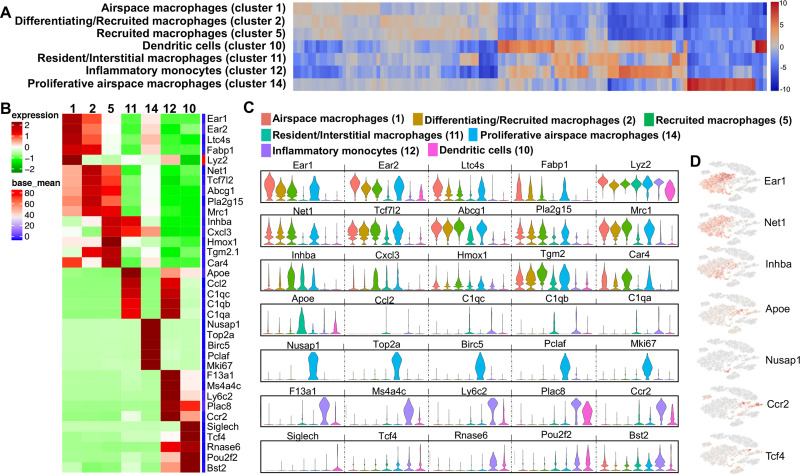
Differences in transcript levels among monocyte-macrophages and dendritic cell (DC) populations.(A) Heatmap shows the top 120/N upregulated genes for 7 macrophages/monocytes and DC clusters ranked by log2 fold-change, where N = total number of clusters. (B) Heatmap showing differences among top 5 genes with gene names of the macrophages/monocytes and DC populations. (C) Expression levels with violin plots among airspace macrophages (red, cluster 1), differentiating/recruited macrophages (brown, cluster 2), recruited macrophages (green, cluster 5), resident/interstitial macrophages (teal, cluster 11), proliferative airspace macrophages (light blue, cluster 14), inflammatory monocytes (lavender, cluster 12), dendritic cells (pink, cluster 10). The y-axis indicates normalized expression value, log2 (average UMI count + 1). (D) Distribution of respective cell populations by a representative gene in t-SNE plot.